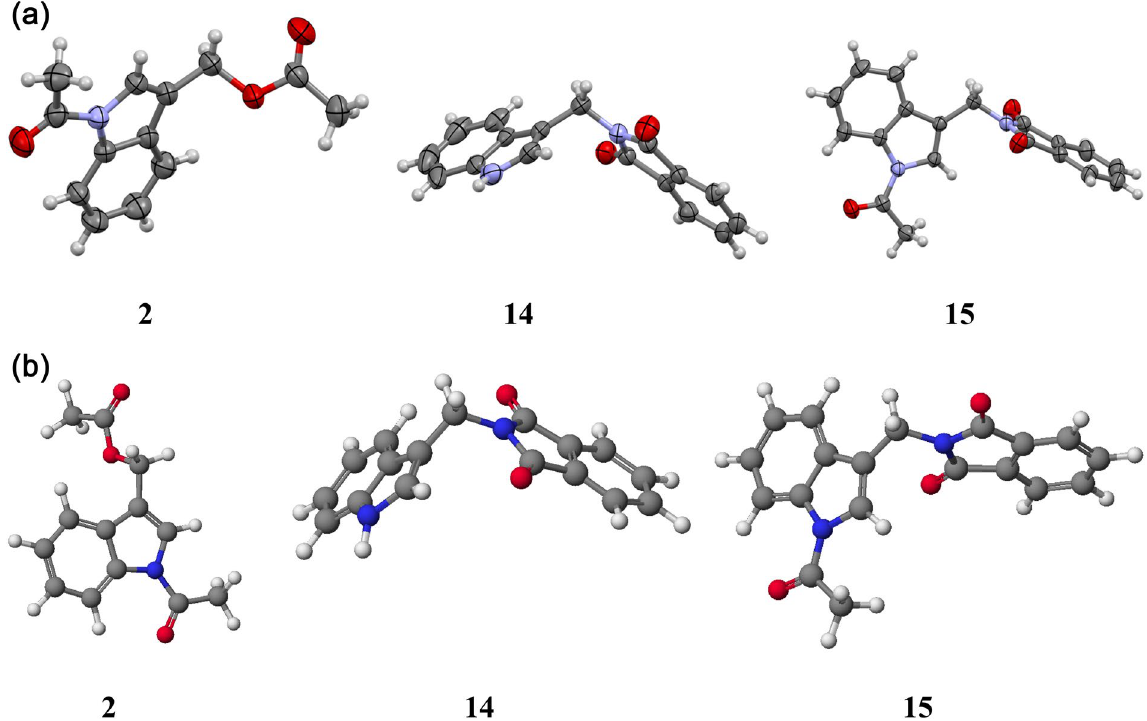
Figure 2. ( a ) Molecules of 2 , 14 , and 15 present in crystals at 293 K. Thermal ellipsoids are drawn at a 40% probability level. H-atoms are presented in arbitrary radii. (Computer graphics program MERCURY) 38 . ( b ) A perspective view of gramine derivatives 2 , 14 , 15 calculated by semiempirical PM5 method (WinMopac 2003) 39